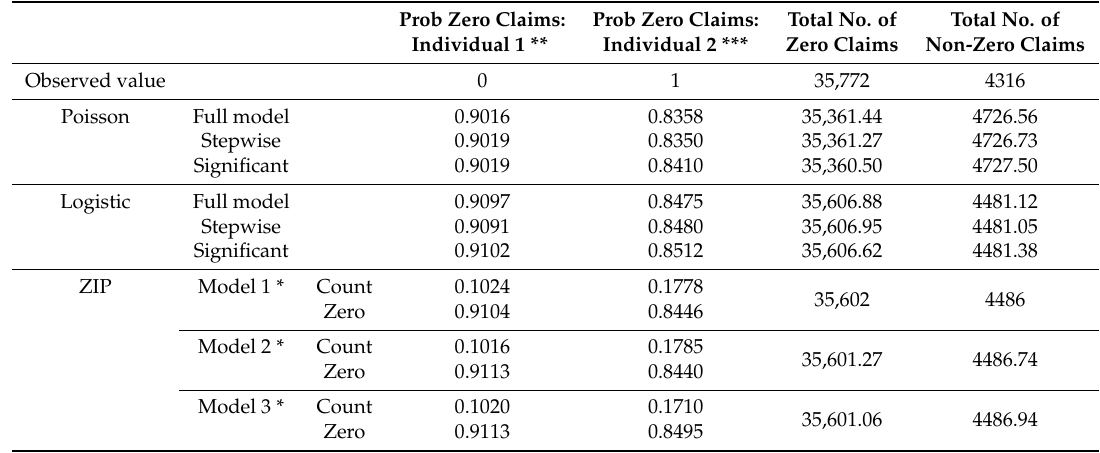
Table 7. Prediction of the probability and the number of zero claims by our models. Prob Zero Claims: Prob Zero Claims: Total No. of Total No. of Individual 1